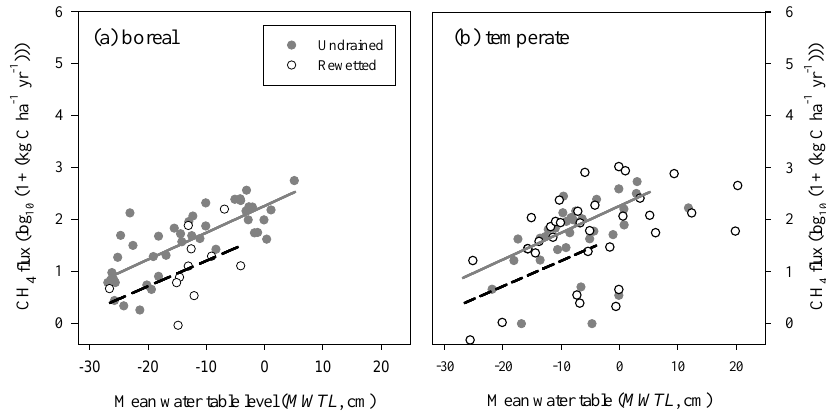
Figure 2. Relationships between annual methane (CH 4 ) fluxes (log 10 (1 + (kg C ha -1 yr -1 ))) and mean water table level ( MWTL , cm) for undrained and rewetted organic soils in (a) boreal and (b) temperate climate zones. Solid grey and dashed lines are the regression lines for the undrained and rewetted sites respectively. Regression equations and parameters are shown in Table 1. Negative MWTL indicates mean water table level below the soil surface and positive MWTL indicates mean water table above the soil surface. Positive CH 4 values indicate annual emissions and negative values indicate annual